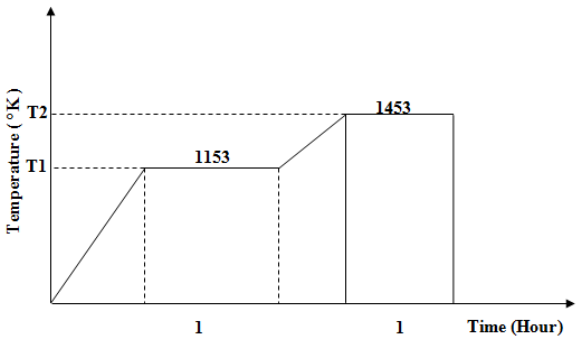
Figure 1. Sintering conditions of the samples sintered at a temperature of 1473